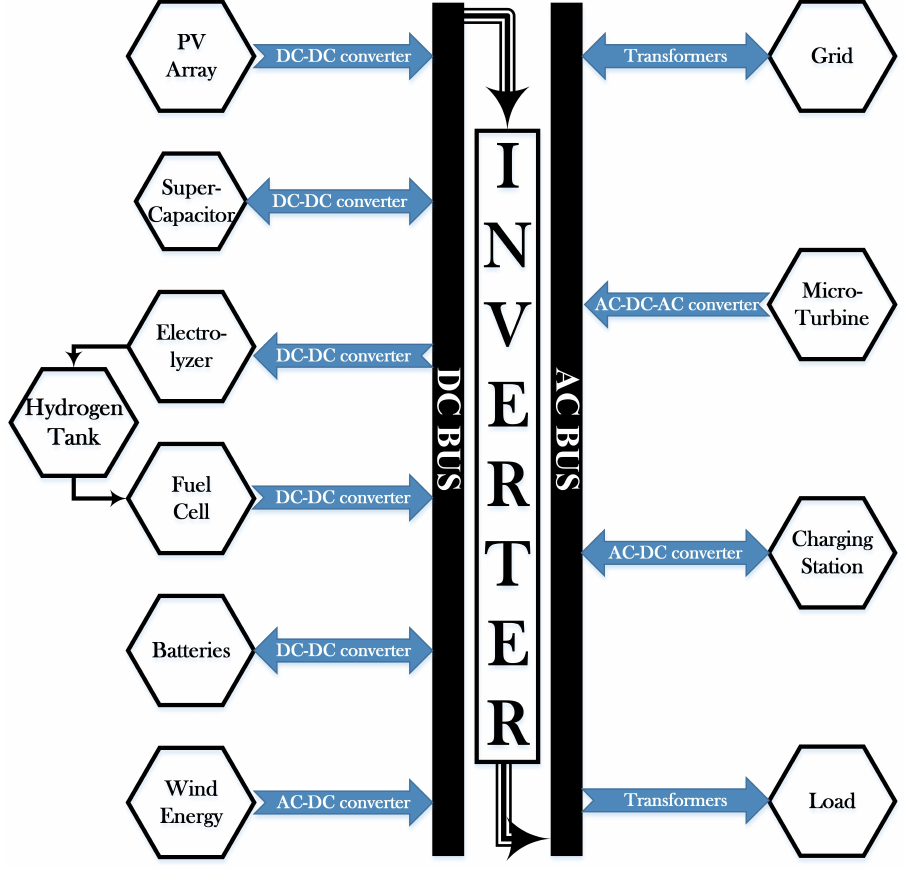
Figure 1. Schematic diagram of the proposed